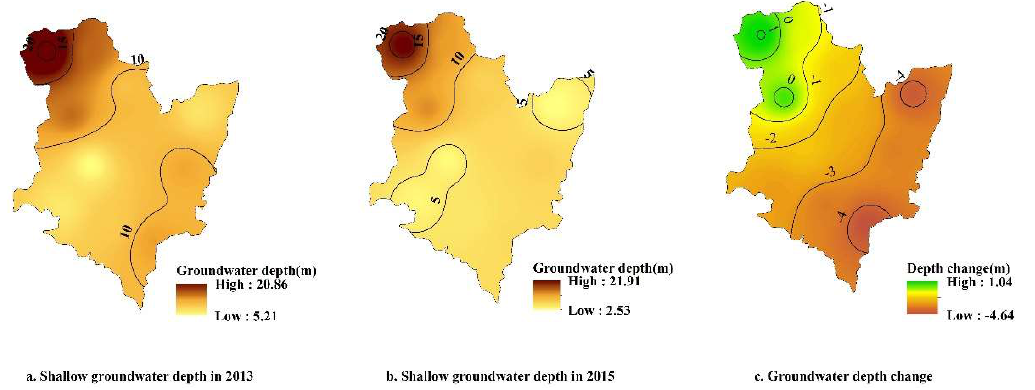
Figure 8. The groundwater depth and the groundwater depth change.